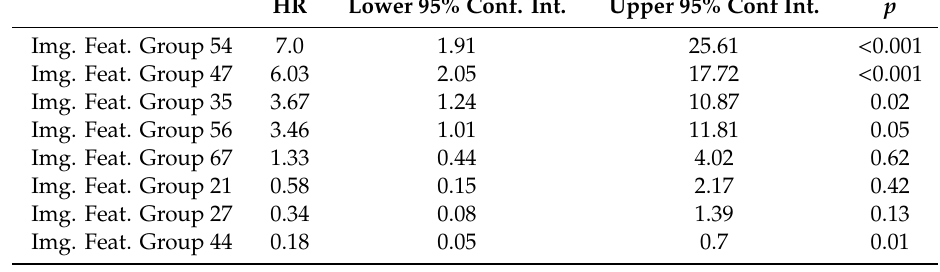
Table 4. Results of the Cox proportional hazards modelling for parameter group 3 (image-derived parameters). HR Lower 95% Conf. Int. Upper 95% Conf Int.